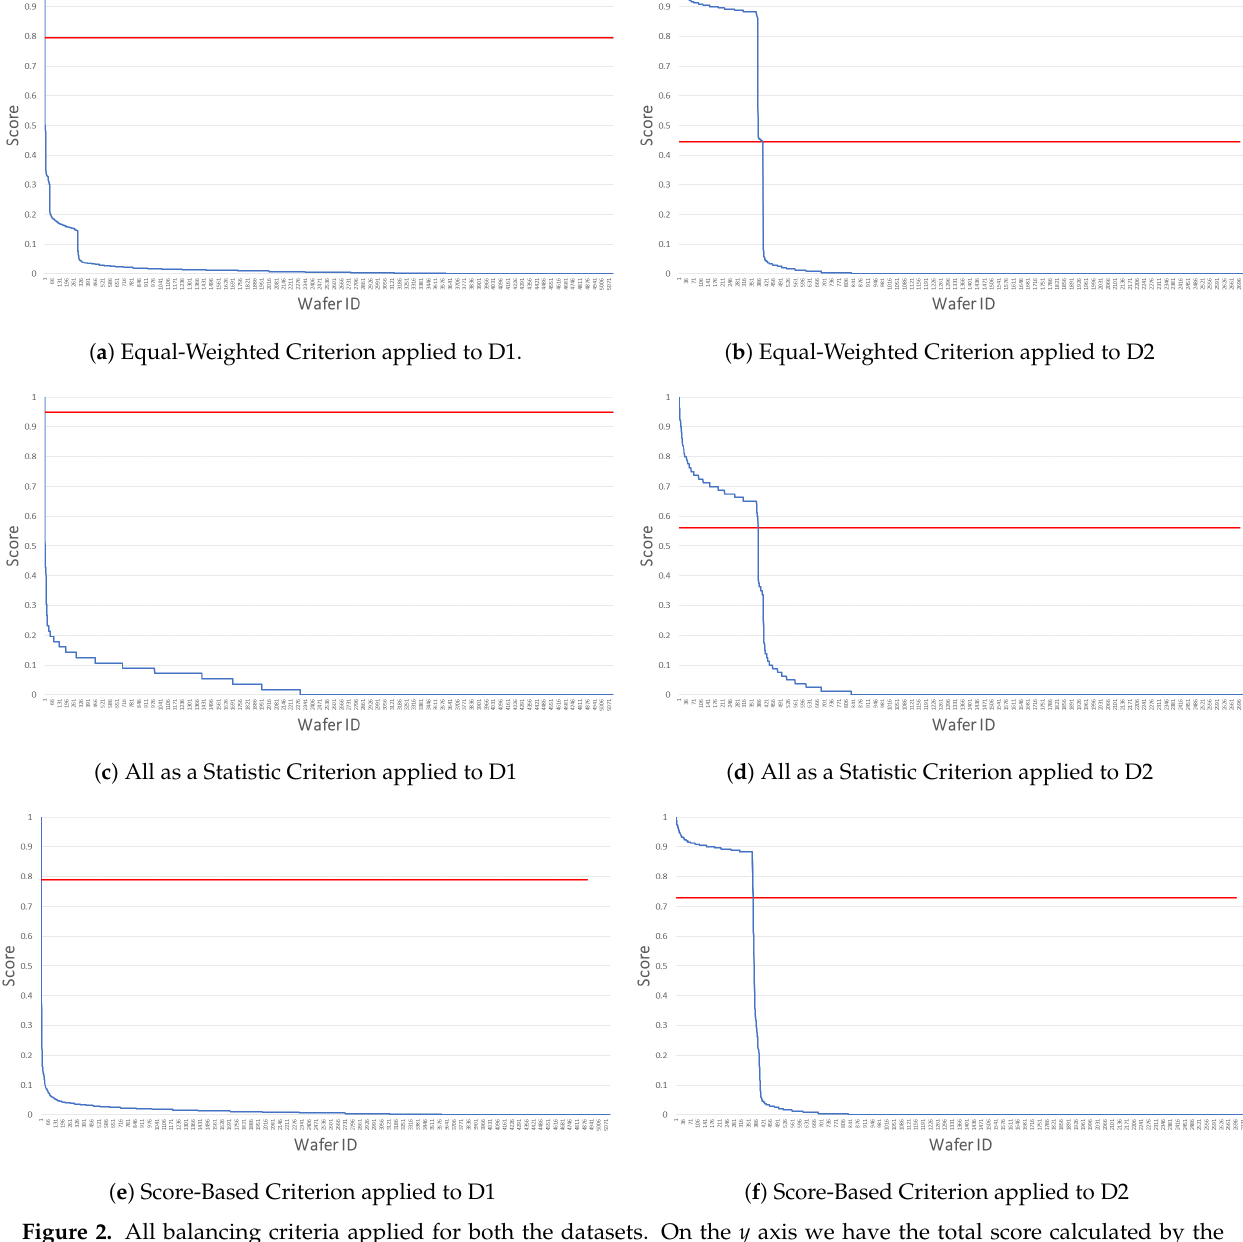
Figure 2. All balancing criteria applied for both the datasets. On the y axis we have the total score calculated by the criterion and on the x axis we have the Material-IDs (reported as increasing Wafer-IDs). In the first row is shown the results of equal-weighted criterion on D1 ( a ) and D2 ( b ), while ( c , d ) show results of All as a statistic criterion in D1 and D2, respectively. The results of the score-based criterion are shown in the final row for D1 ( e ) and D2 ( f